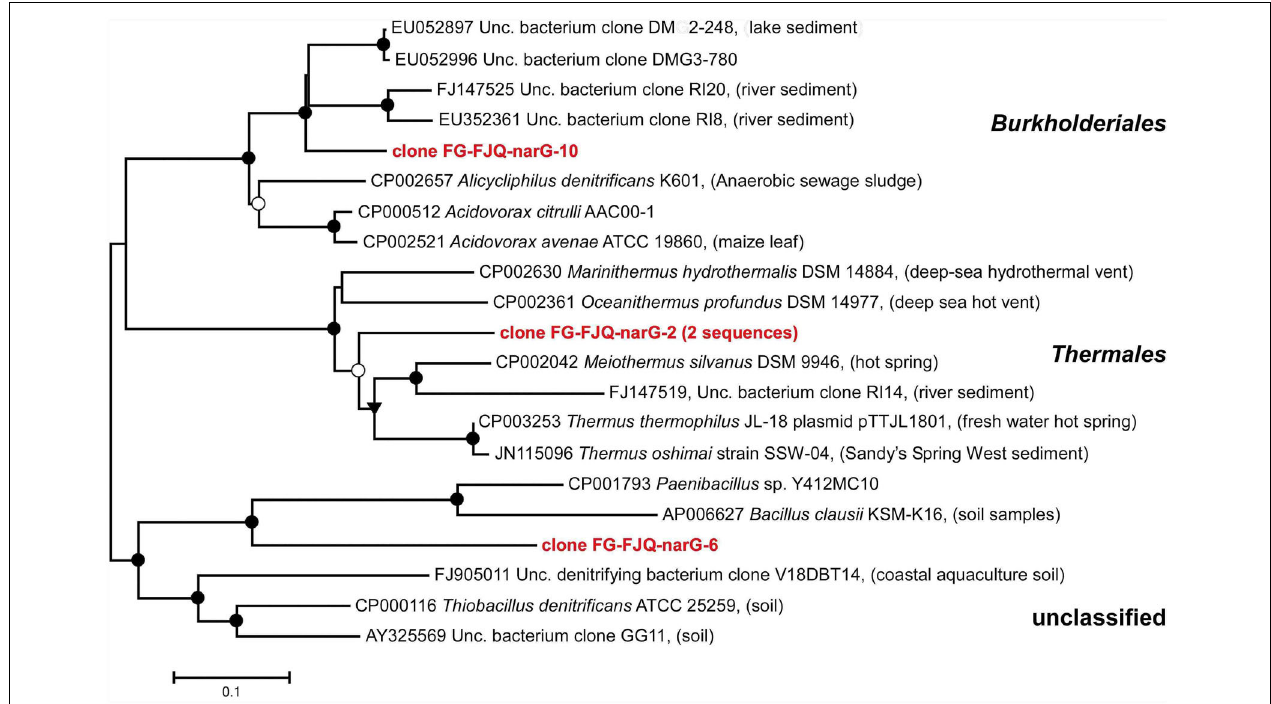
FIGURE 5 | Phylogenetic relationships of the narG sequences obtained from microcosms of the spring FJQ to the closest related narG gene sequences from databases. The tree was inferred by a neighbor-joining analysis of 650 nucleotide positions. Further details are as described in the legend to Figure 3 .